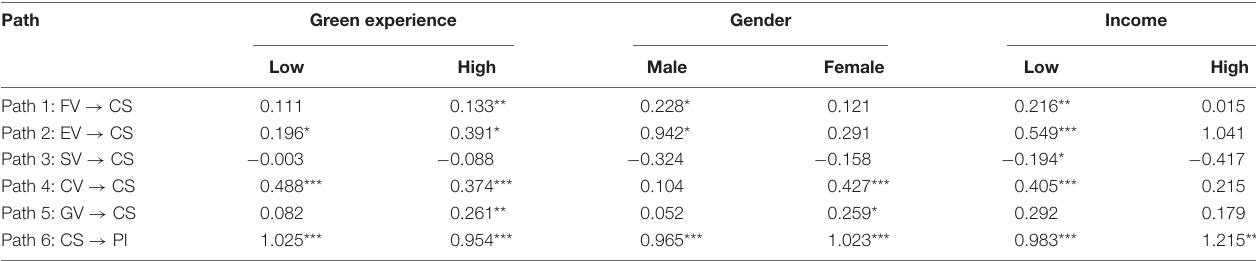
TABLE 7 | The results of multigroup SEM analysis. Path Green experience Gender Income Low High Male Female Low